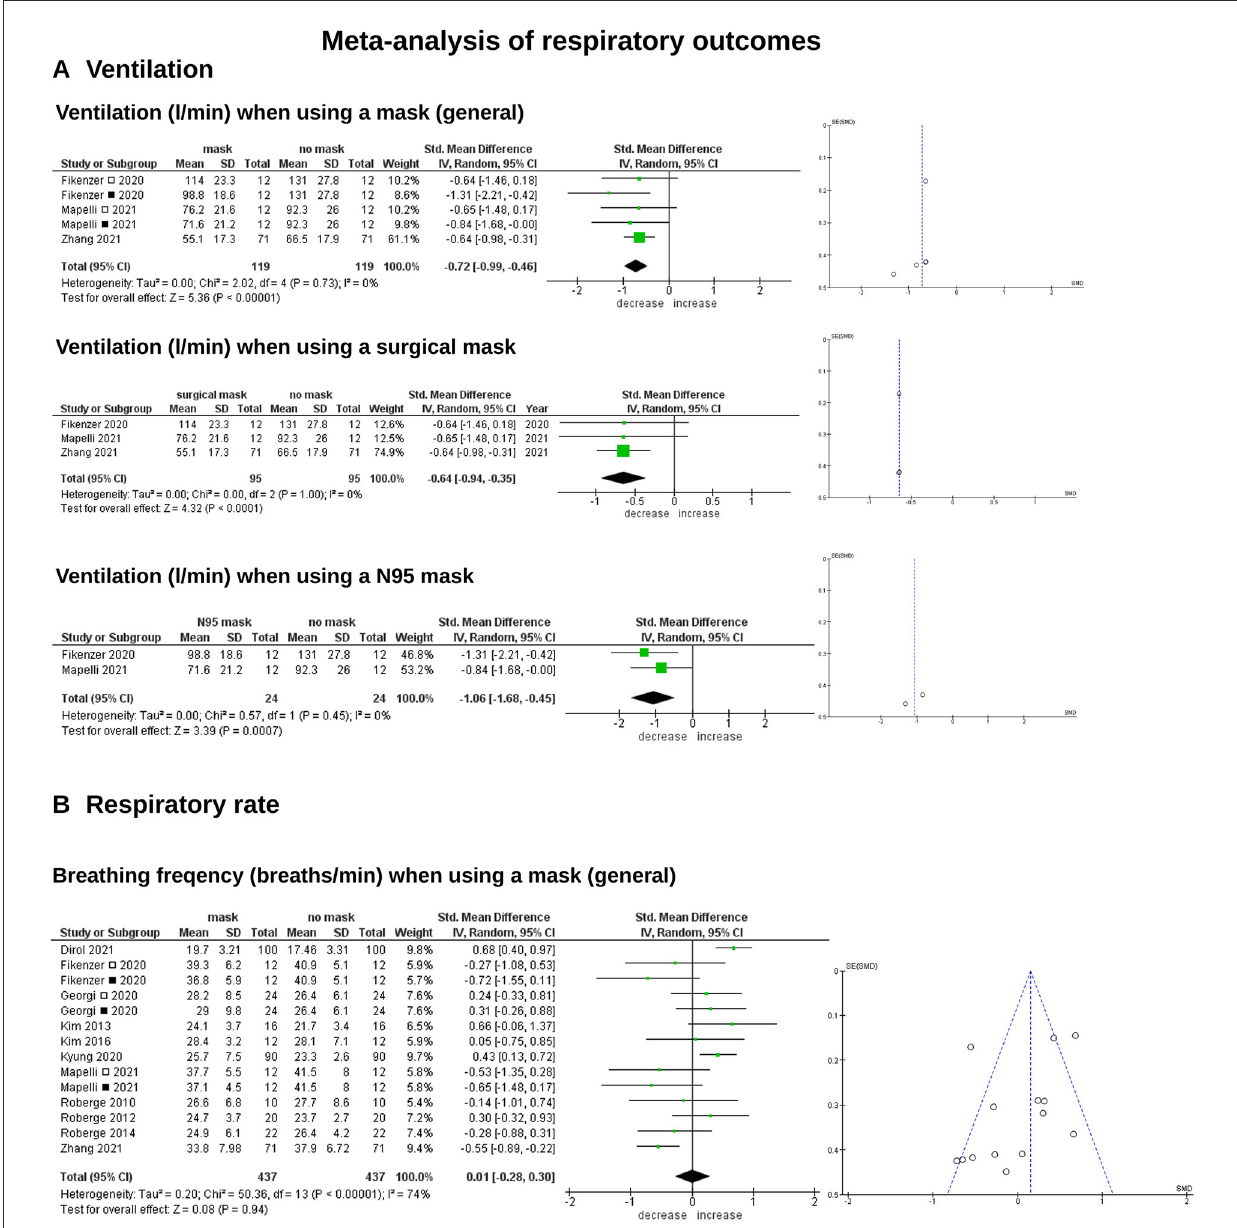
FIGURE3 Forest (left) and funnel plots (right) of meta-analysis of physiological respiratory outcomes while wearing a face mask. (A) Shows results for ventilation (V E ), (B) for respiratory rate (RR). All face mask types are initially considered together, later subgroups (surgical and N95) are evaluated. If studies examine two different mask types in parallel, the corresponding studies are marked: (cid:3) is significantly lowered in mask use in the pooled analysis. This could be found for general, for surgical, and N95 mask use. In studies evaluating both conditions (surgical and N95 mask) the N95 mask yielded always lower ventilation (V E ) than the surgical masks. (B) No statistical difference could be found regarding respiratory rate in mask use in the pooled analysis, even in the subgroup analysis (not